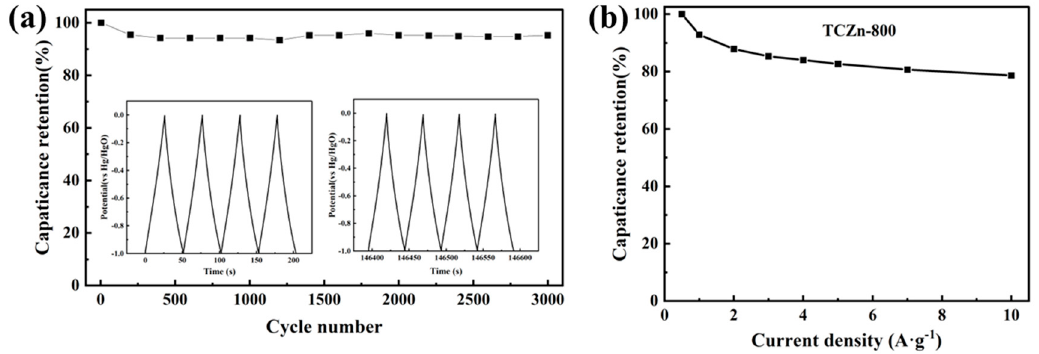
Figure 7. ( a ) 3000-cycle stability test at 5 A · g − 1 and ( b ) the capacitance retention with different current densities of TCZn-800.